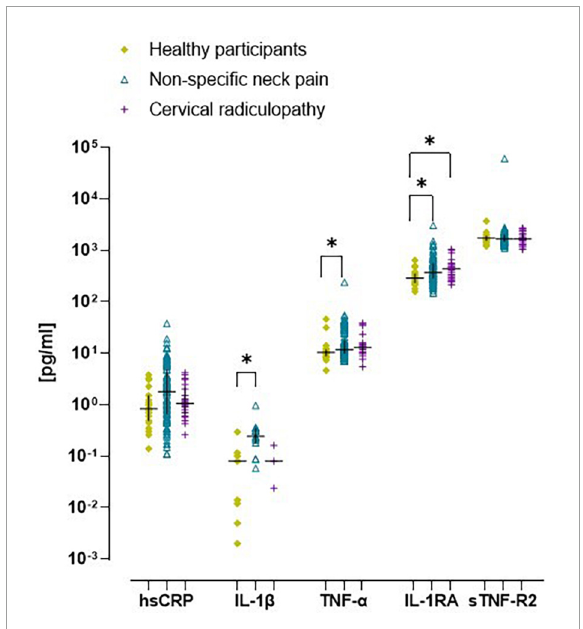
FIGURE2 Scatter plot and median (inter quartile range) of ex vivo concentration of inflammatory markers in healthy participants, people with non-specific neck pain, and cervical radiculopathy. Raw ex vivo data were Ln-transformed before testing for significant differences between groups. Lines represent median ( horizontal line ), and 25th–75th percentiles. hsCRP, high sensitive – c reactive protein; TNF- α , tumor necrosis factor- α ; IL-1 β , interleukin-1 β ; IL-1RA, interleukin one-receptor antagonist; sTNF-R2, tumor necrosis factor – receptor two. ∗ p < 0.05. The scatter plot was based on the individual points of 112 people with non-specific neck pain, 25 with cervical radiculopathy and 23 healthy